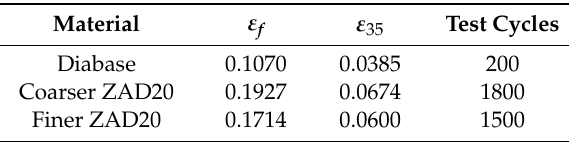
Table 3. Test cycles according to the material used.